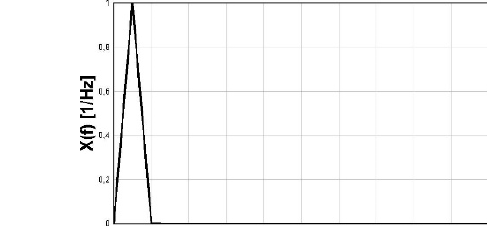
Figure 1. Harmonic sine function ( left ) and its FFT form ( right ).